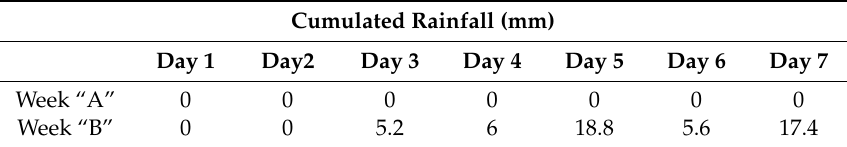
Table 5. Cumulated daily rainfall (mm) for two weeks: week “A” and week